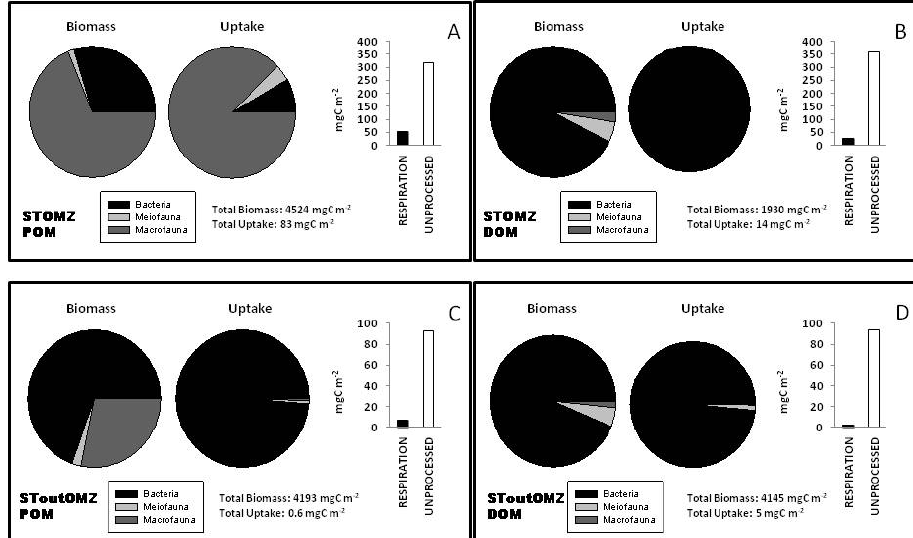
Fig. 4. Comparison between stations and treatments and overview of the benthic community structure and functioning. Biomass values are calculated per treatment and whole core to allow direct comparison with uptake